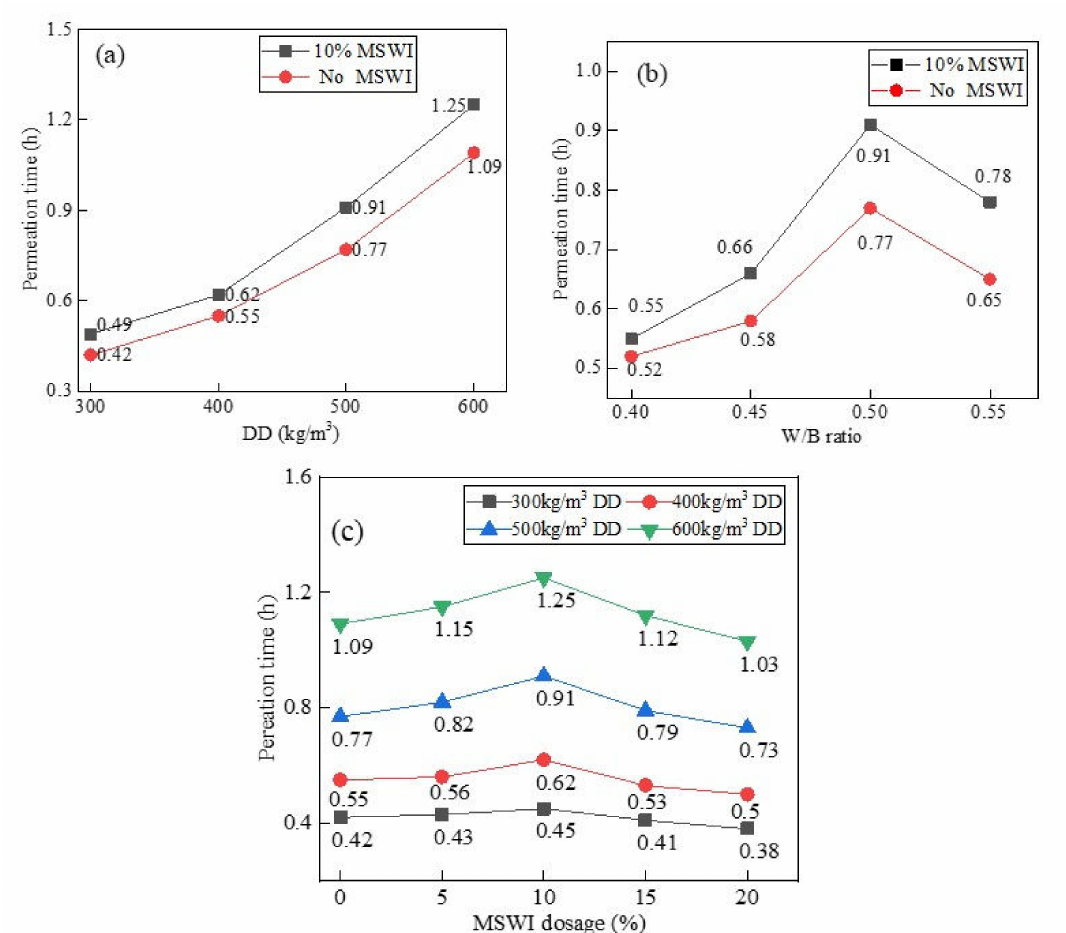
Figure 10. Impermeability of the recycled foamed concrete containing MSWI powder with different dry densities ( a ), W/B ratios ( b ), and MSWI powder dosages ( c